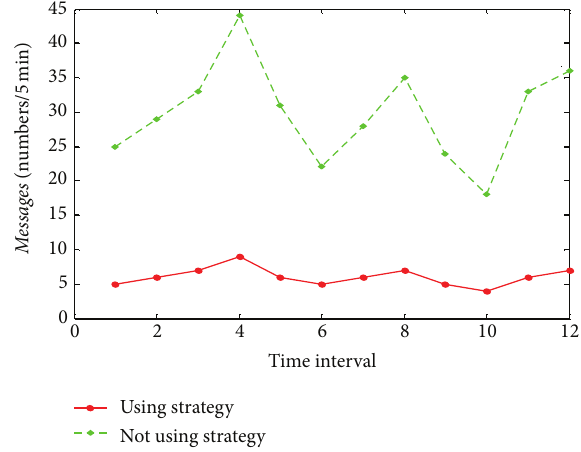
Figure 7: Messages of the 7th vehicle before and after using position updating strategy.